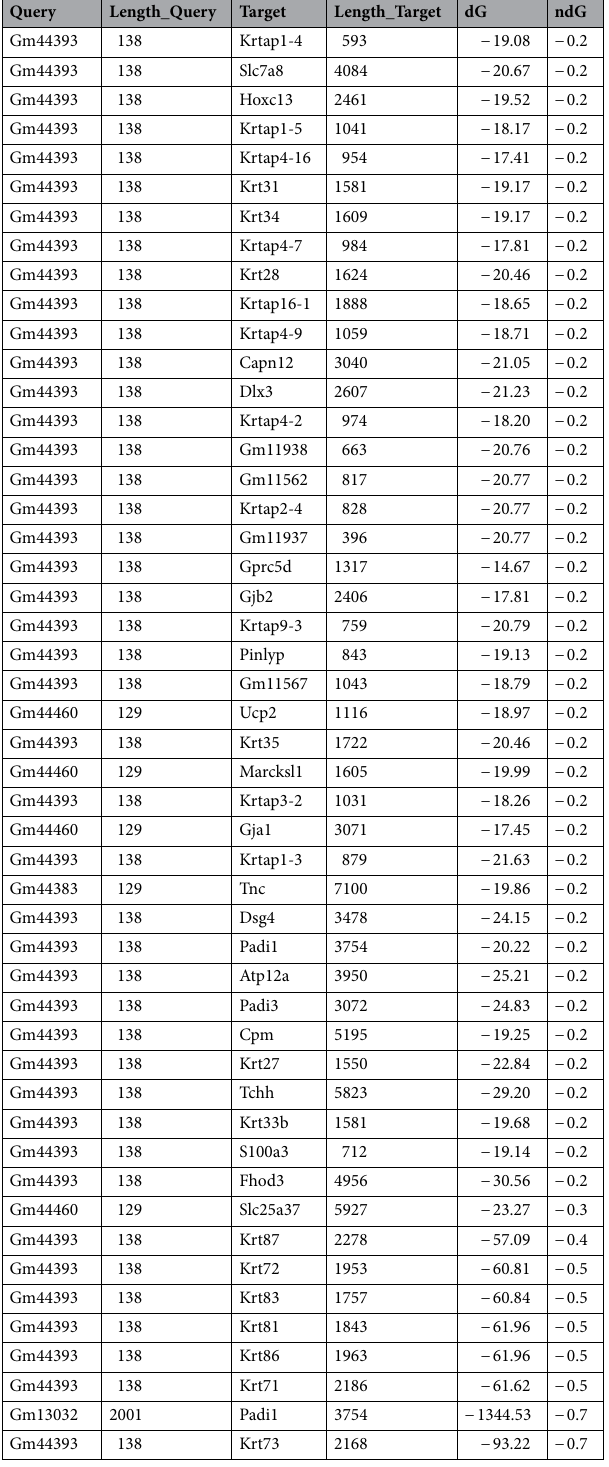
Table 4. Theoretical hybridization energy required to form ncRNA-mRNA pairs after PBS